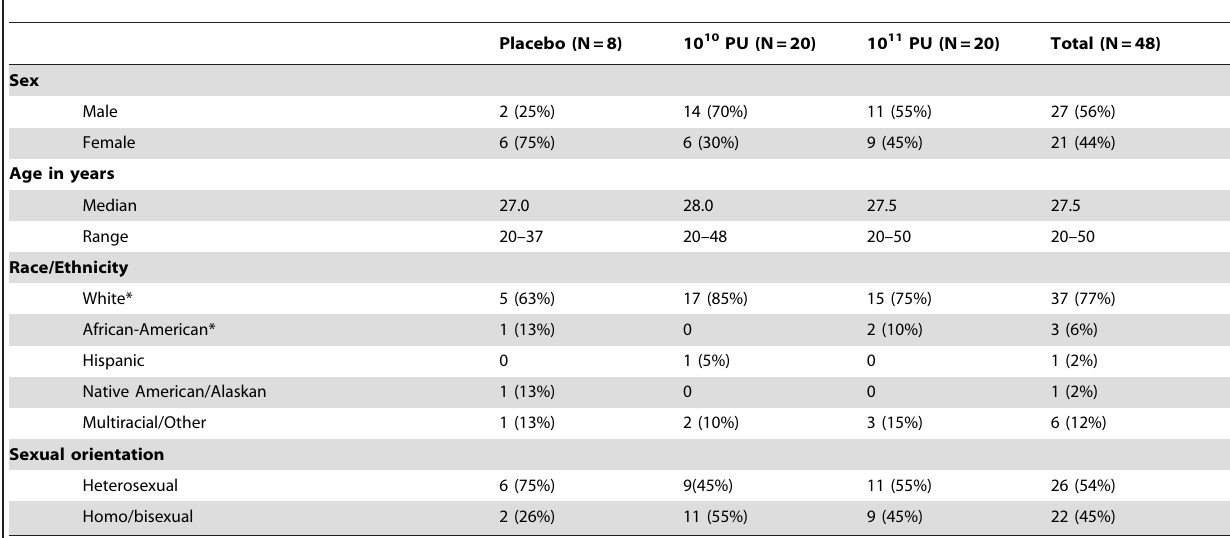
Table 1. Demographic characteristics of the study